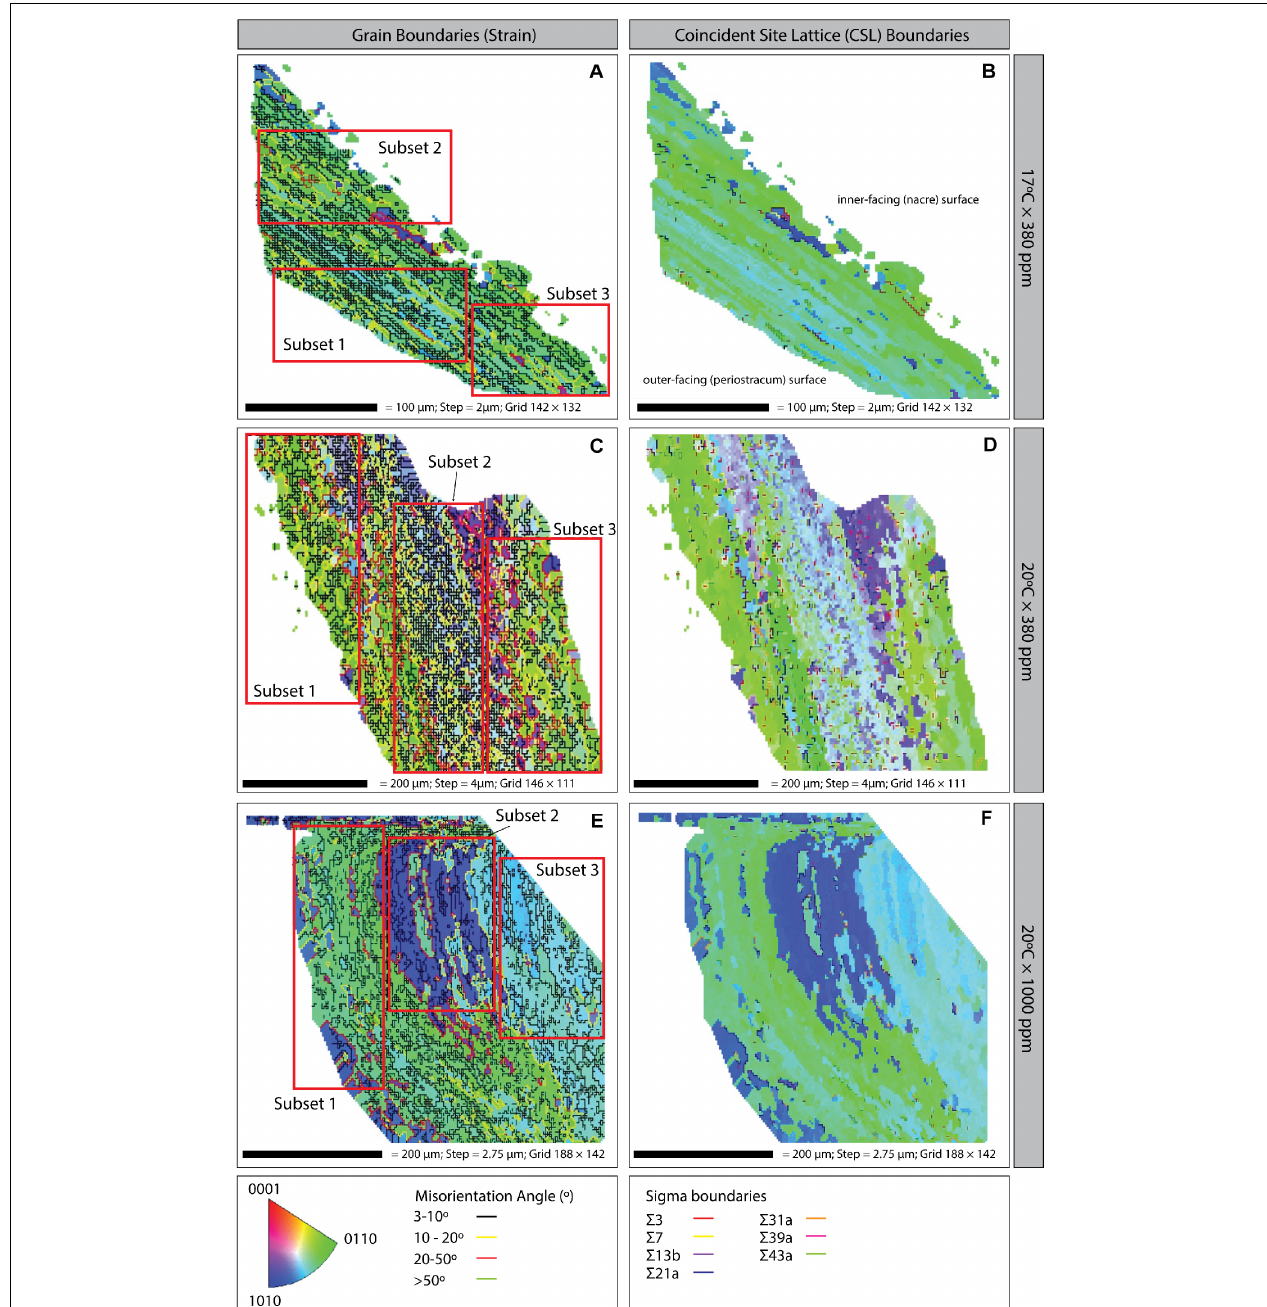
FIGURE 5 | Inverse pole figure (IPF) maps with grain boundaries (left column) and coincident site lattice (CSL; right column) boundaries of Mytilus sp. shell samples grown under three climate scenarios: (A,B) 17 ◦ C × 380 ppm (Control); (C,D) 20 ◦ C × 380 ppm (Ocean warming without acidification); and (E,F) 20 ◦ C × 1000 ppm (Ocean warming with acidification). Bottom: Crystal orientation color inset key; grain boundary misorientation (strain) angles; and CSL Sigma boundaries (right column). All plots are orientated in the same way i.e., the left-hand side of the image is the outer-facing periostracum surface and the right-hand side is the inner-facing (nacre) surface (as illustrated on panel B